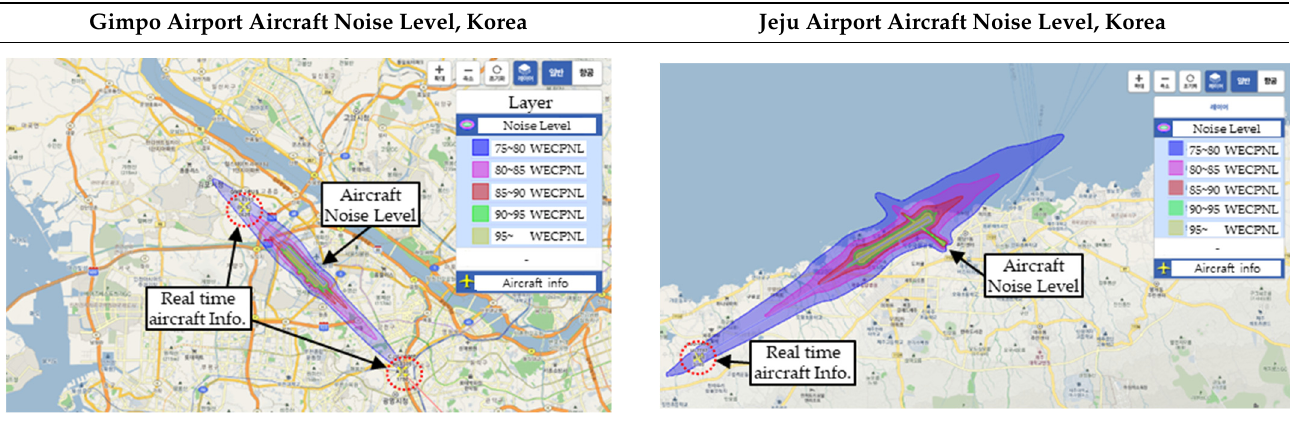
Table 4. Real-time aircraft noise at Gimpo and Jeju Airports (as of 14 p.m., 25 August 2022 https://www.airportnoise.kr/anps/gis).